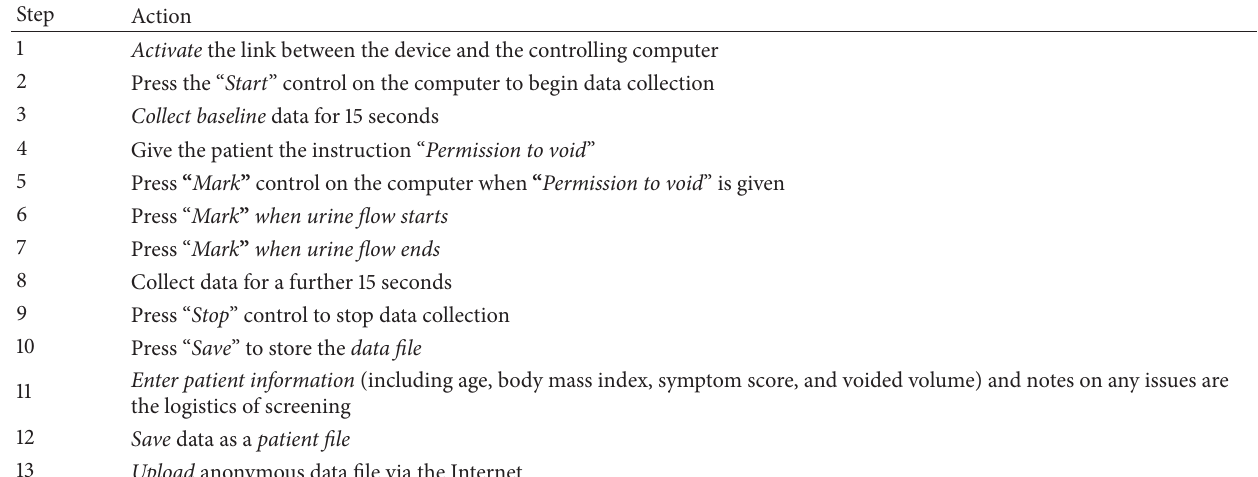
Table1:NIRSbladderscreeningprotocol.Thesequenceofactions,commands,andcomputerentriesrequiredfromtheoperatorforcollection of each data set once the device is applied to the skin over the bladder and the patient is standing ready to void.